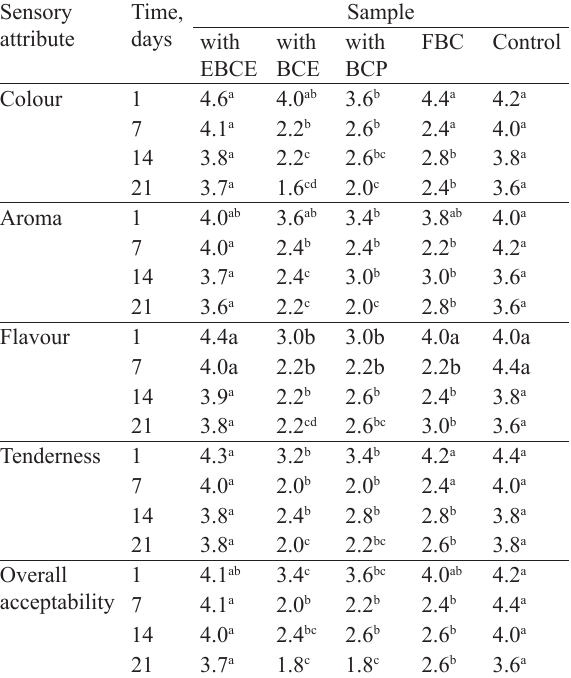
Table 4 Sensory evaluation of kolompeh samples during